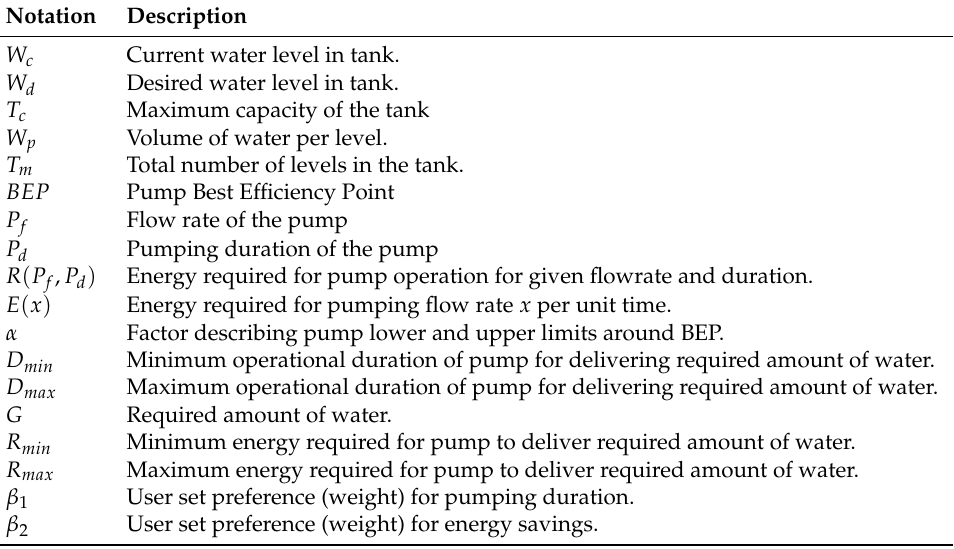
Table 1. Description of notations used in